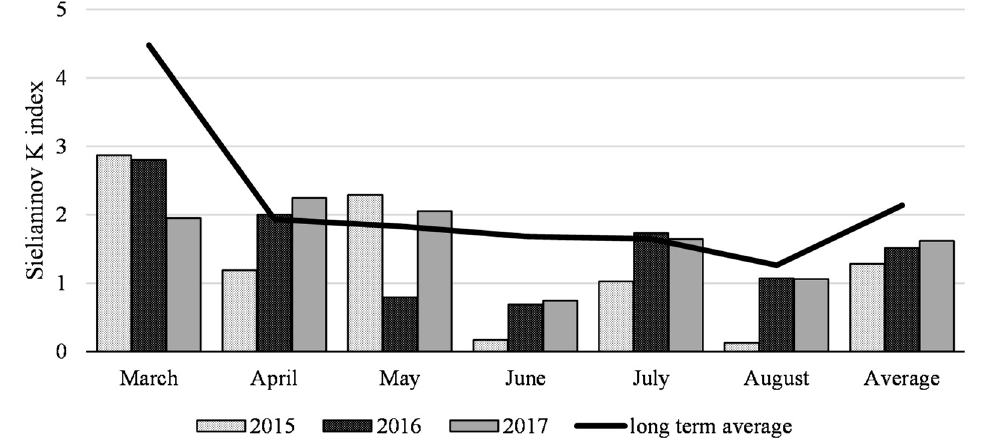
Figure 1. The hydrothermal index (K) during the growing season of pea. Sielianinov index (K): K ≤ 0.4 extremely dry (ed), 0.4 < K ≤ 0.7 very dry (vd), 0.7 < K ≤ 1.0 dry (d), 1.0 < K ≤ 1.3 relatively dry (rd), 1.3 < K ≤ 1.6 optimal (o), 1.6 < K ≤ 2.0 relatively humid (rh), 2.0 < K ≤ 2.5 humid (h), 2.5 < K ≤ 3.0 very humid (vh), and K > 3.0 extremely humid (eh). Table 2. Morphological features of pea seeds depending on the variety, fertilization, and years of research. Variables